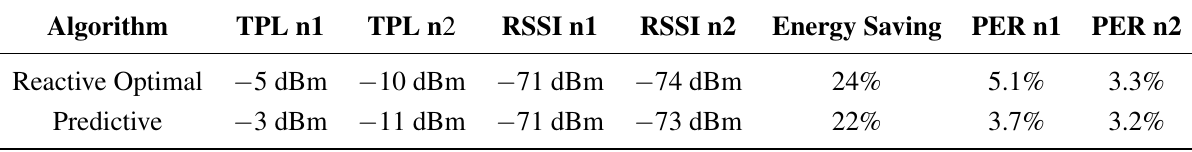
Table 6. Simulation results for the case study. Transmission Power Levels (TPL) , node 1 (n1) and node 2